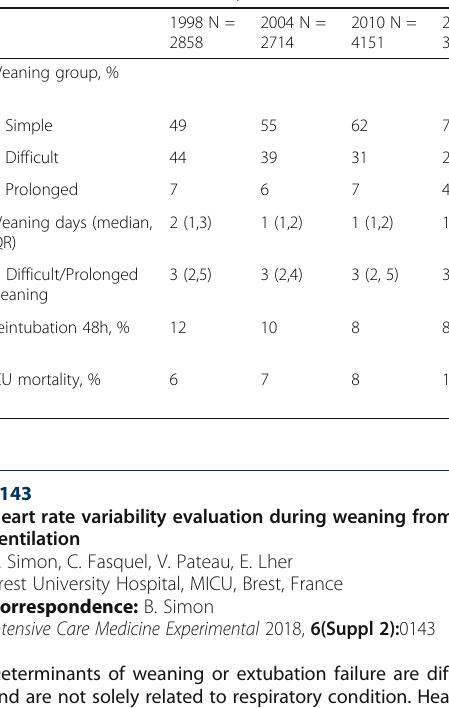
Table 2 (abstract 0142). Comparison of outcomes